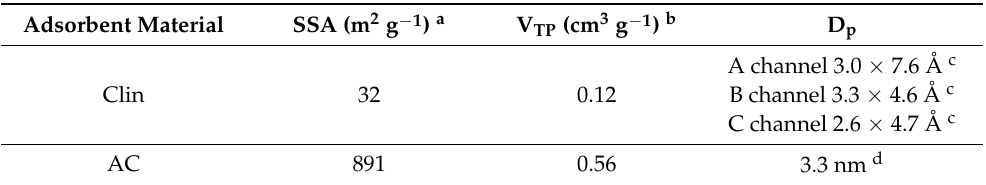
Table 1. Specific Surface Area (SSA), Total Pores Volume (V TP ), and Total Pores Diameter (D TP ) of the Clin and AC samples.